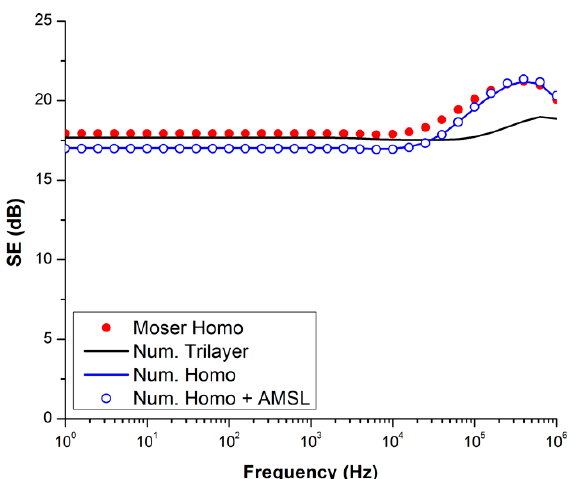
Figure 6. Shielding effectiveness of the homogenized layer (red dot) obtained with Moser model, and of the trilayer composite (black), the homogenized layer (blue), and the artificial layer (blue dot) obtained in near-field with the numerical model.